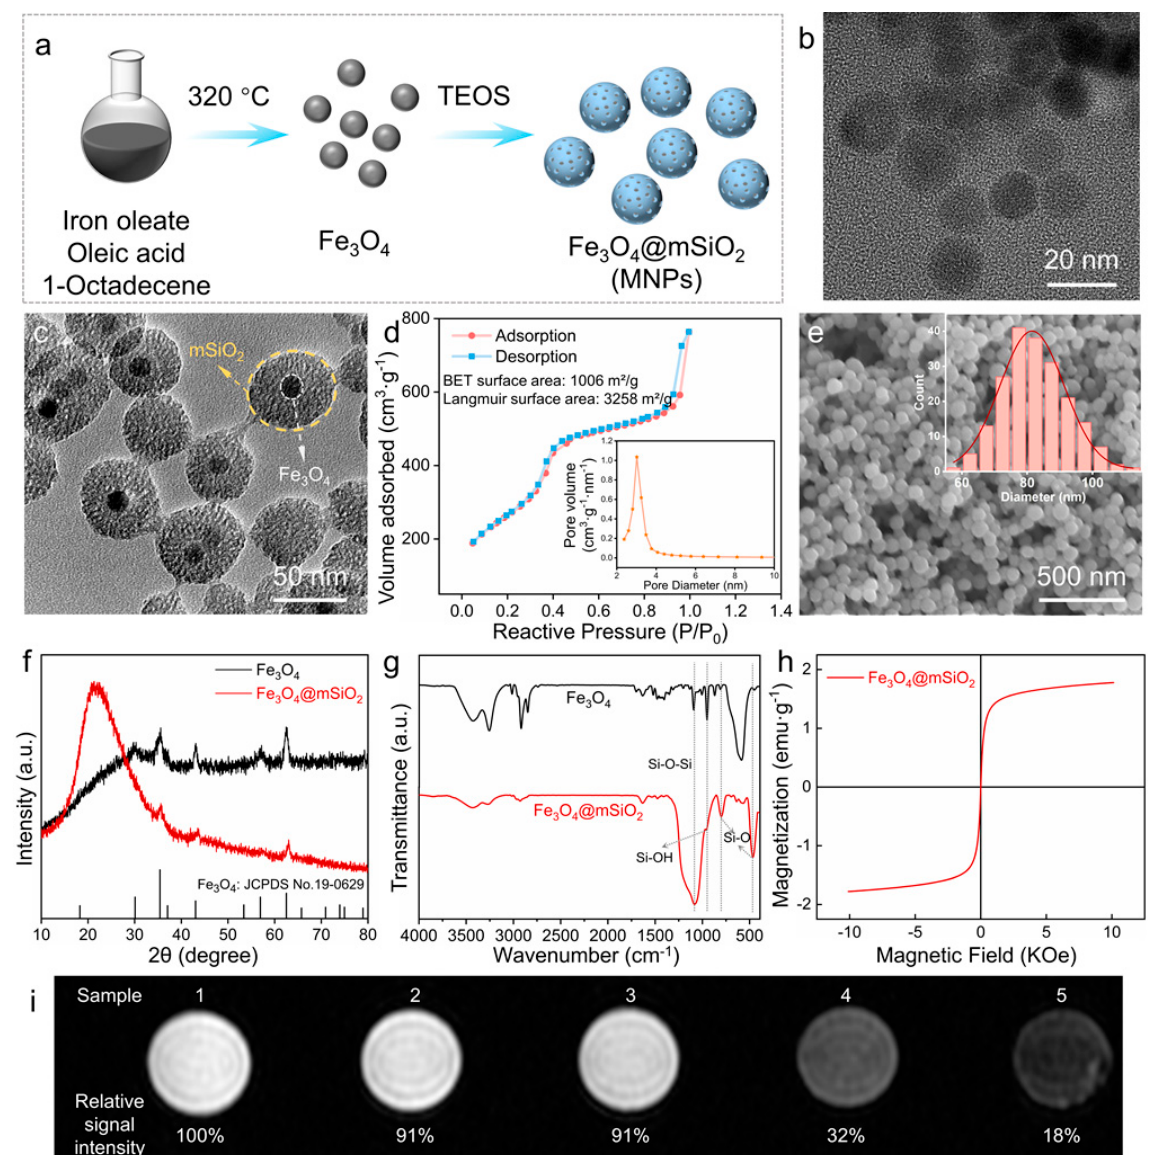
Figure 1. Synthesis and characterization of MNPs. ( a ) Schematic illustration of the preparation process of MNPs. ( b , c ) Transmission electron microscopy (TEM) images of Fe 3 O 4 and MNPs, respectively. ( d ) N 2 adsorption–desorption isotherms and mesopore size distribution (the inset) of MNPs. ( e ) Scanning electron microscope (SEM) image and particle diameter distribution (the inset) of MNPs. ( f ) The X-ray diffraction (XRD) patterns and ( g ) the Fourier transform infrared spectra (FTIR) images of Fe 3 O 4 and MNPs. ( h ) Saturation magnetization curve of MNPs at room temperature. ( i ) T 2 -weighted magnetic resonance imaging (MRI) images of different samples. Samples 1 to 5 represent water, silica of 75 and 150 µ g/mL, and MNPs of 75 and 150 µ g/mL,